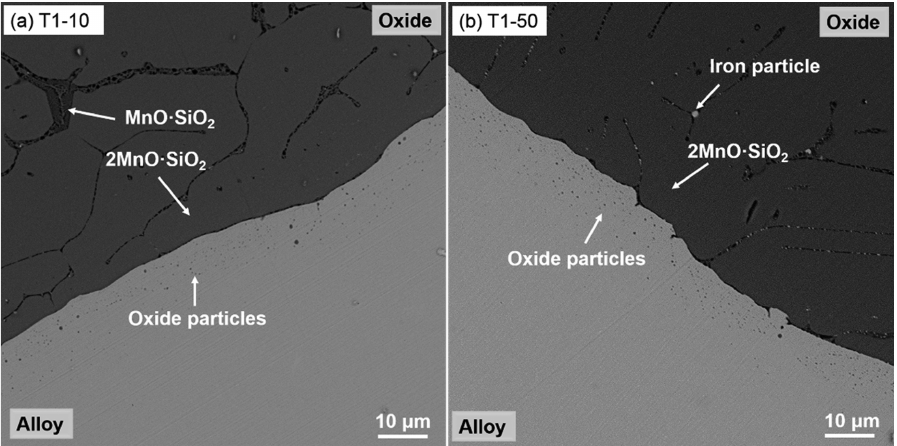
Figure 4: Morphology of the interface between the oxide and alloy after heat treatment at 1173K for (a) 10h and (b) 50h.